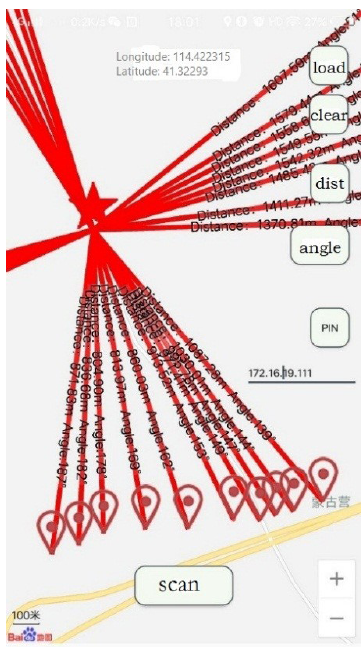
Figure 4. Custom map, positioning, angle measurement and rang- ing (© Baidu Maps2019).